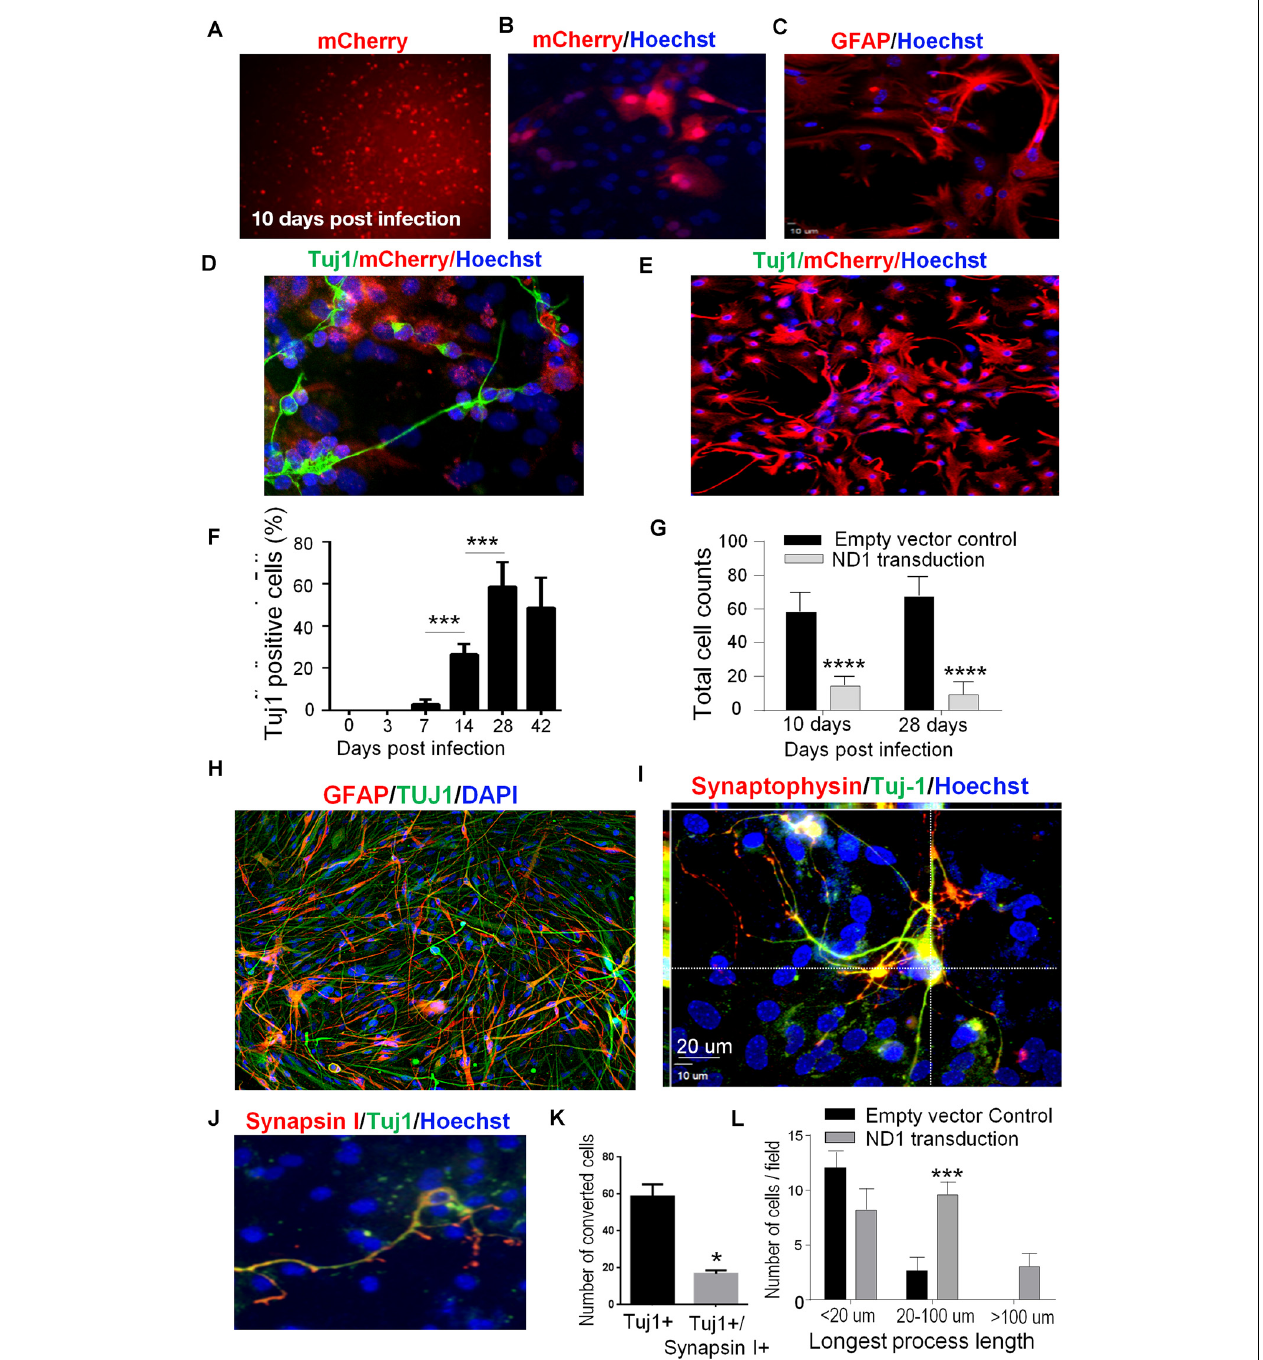
FIGURE 1 | In vitro direct reprogramming of astrocytes to induced neurons. Mouse astrocyte cultures were transduced with NeuroD1 (ND1) or empty vector control and stained for different cell markers. (A) Ten days after lentiviral transduction, successfully infected cells were monitored over time by the expression of the fluorescent mCherry reporter (red), implicating GFAP-ND1-IRES-Ubi-mCherry expression in these astrocytes. (B–D) Enlarged images of infected cells 14 days after transduction. Infected cells expressed the reporter gene mCherry (B) , GFAP stain revealing an astrocyte-like morphology of astrocytes before reprogramming (C) . In image (D) , some cells develop the neuronal lineage marker Tuj1 (green) and adopted either a unipolar or bipolar morphology that is uncharacteristic of astrocytes. (E) A representative image of control culture with the empty vehicle virus showing the lack of Tuj-1 expression in infected cells (mCherry, red). There were also no alterations to the morphology of astrocytes. (F) Time course and reprogramming rate of the expression of the immature neuron marker Tuj1 in infected astrocytes up to 42 days after transduction. One-way ANOVA ( F (5,36) = 77.91) followed by Holm–Sidak’s multiple comparisons test. N = 3 independent cell culture